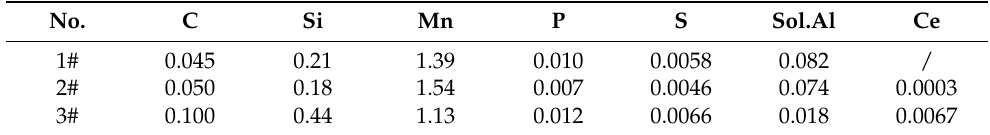
Table 1. Composition of samples (mass percentage/%).